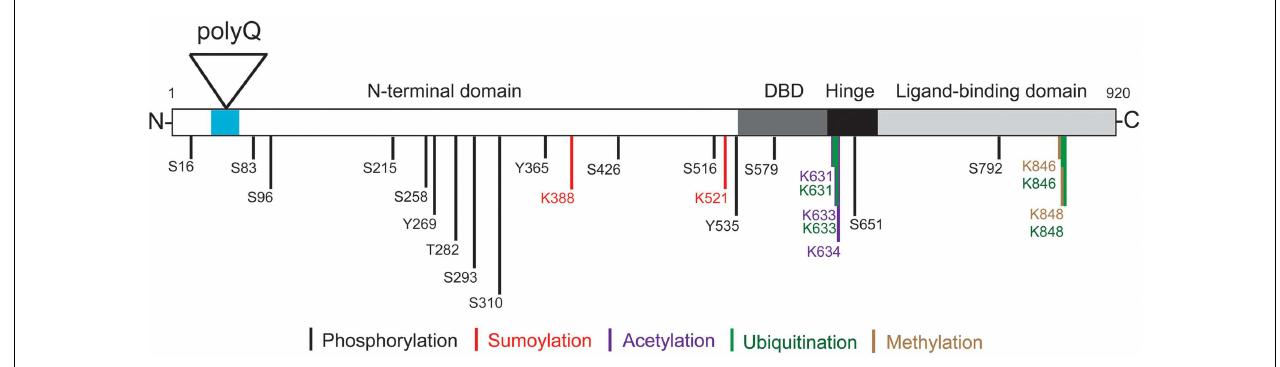
on serine (S), threonine (T), and tyrosine (Y) residues. Specific lysine (K) residues can be acetylated, ubiquitinated, sumoylated, or methylated as indicated. Note the amino acid numbering is based on a 920 amino acid AR (NCBI Reference Sequence: NM_000044.3) (Gottlieb et al.,